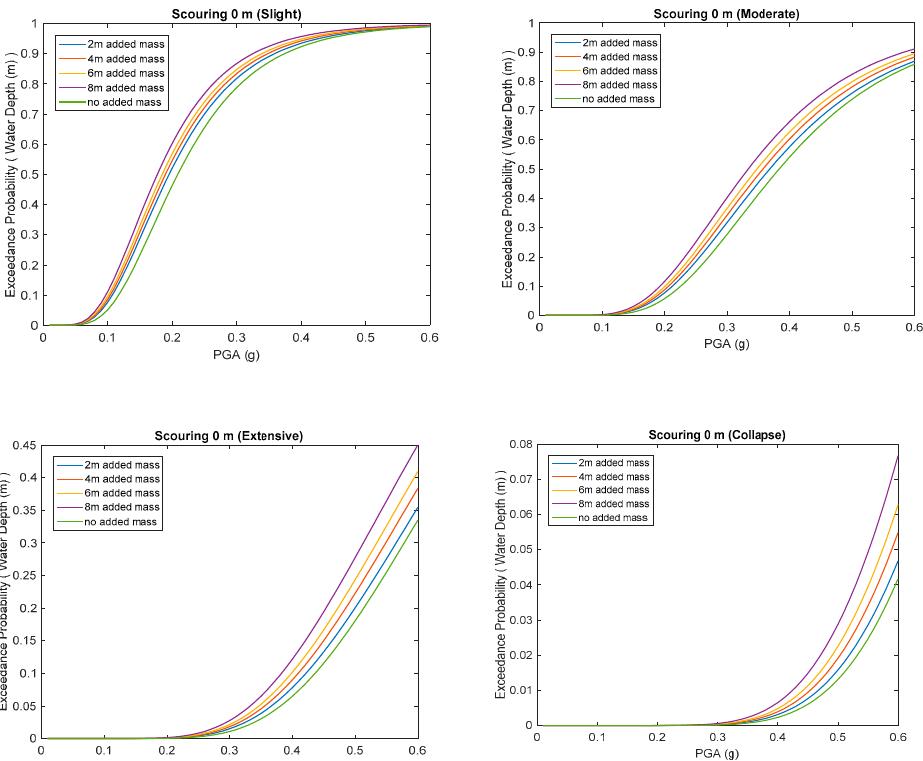
Figure 18. Fragility curves of each water level under 0 m scouring depth and the same performance level. Appl. Sci. 2019 , 9 , x FOR PEER REVIEW Table 1. Result values from the training.